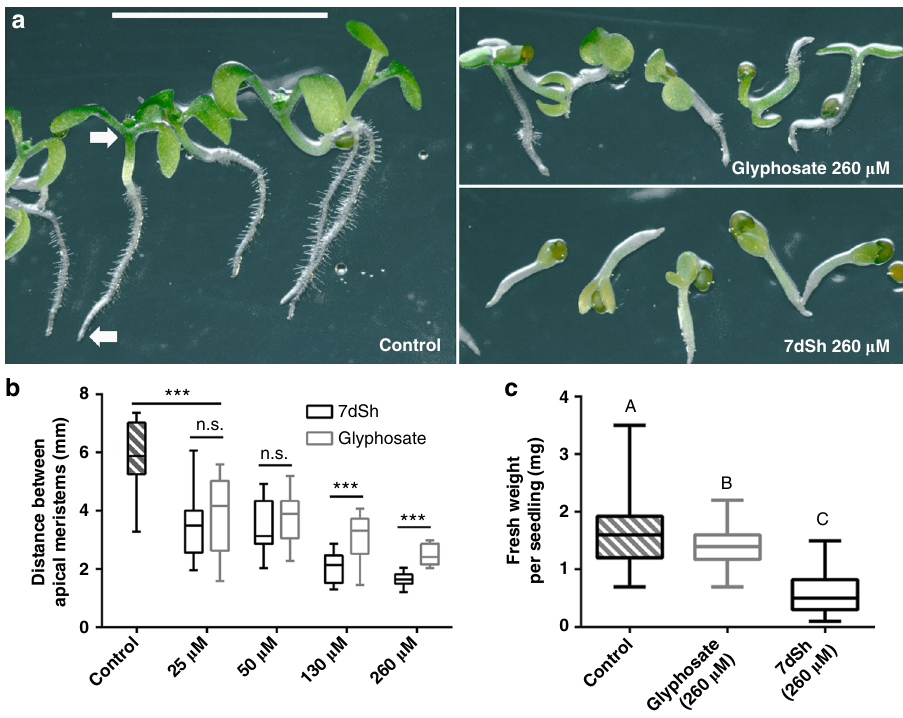
Fig. 6 7dSh ( 1 ) reduces the growth of A. thaliana seedlings. a Morphological appearance of autotrophically grown Arabidopsis thaliana seedlings 7 days after induction of germination. Seedlings were grown in constant light on agar plates without an antimetabolite (control) or in the presence of 7dSh or glyphosate. Plates were mounted vertically and illuminated from above. White arrows mark the root and shoot apical meristem. Scale bar (5 mm) applies to all images. b Measurement of the distance between root and shoot apical meristem. Signi fi cant differences between seedling sizes were analyzed in